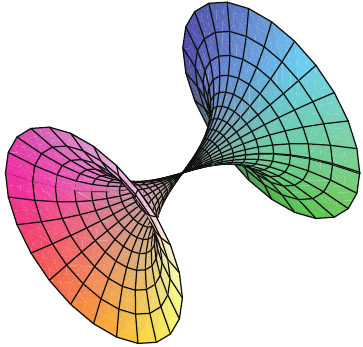
Figure 3: The catenoid of the 3rd kind.